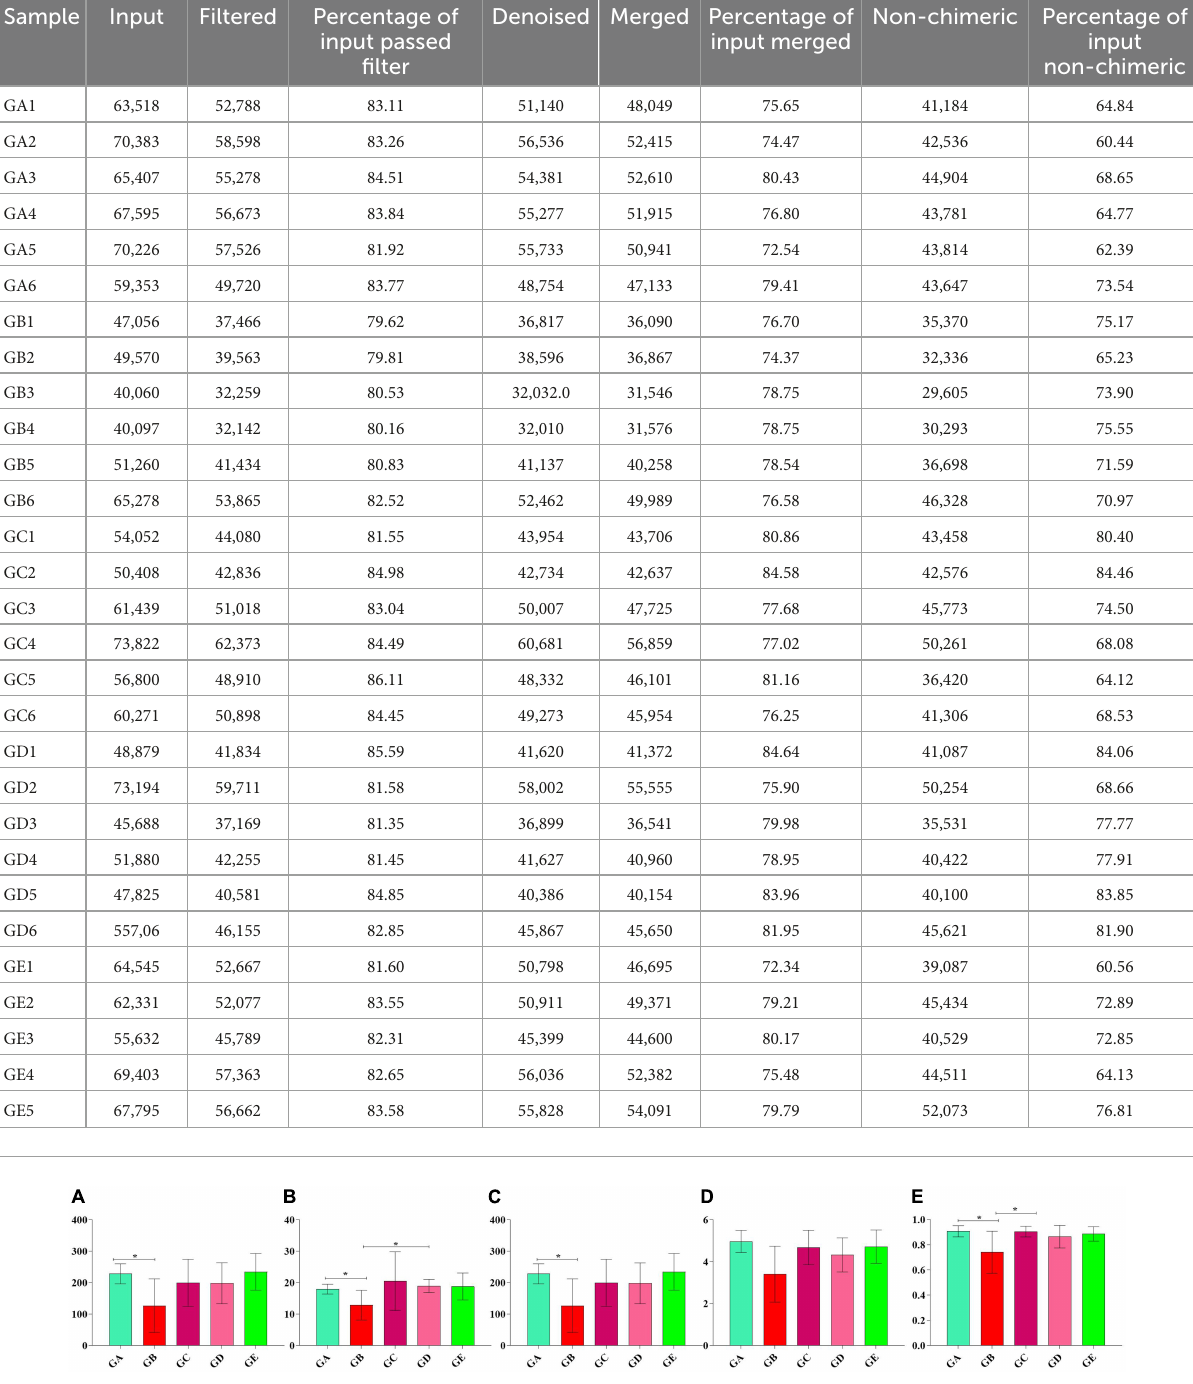
FIGURE4 Alpha diversity analysis of mice gut microbiota in different groups. (A) chao1, (B) faith_pd, (C) observed_otus, (D) shannon, (E) simpson. Significance is presented as * p < 0.05; data are presented as the mean ± SEM ( n =